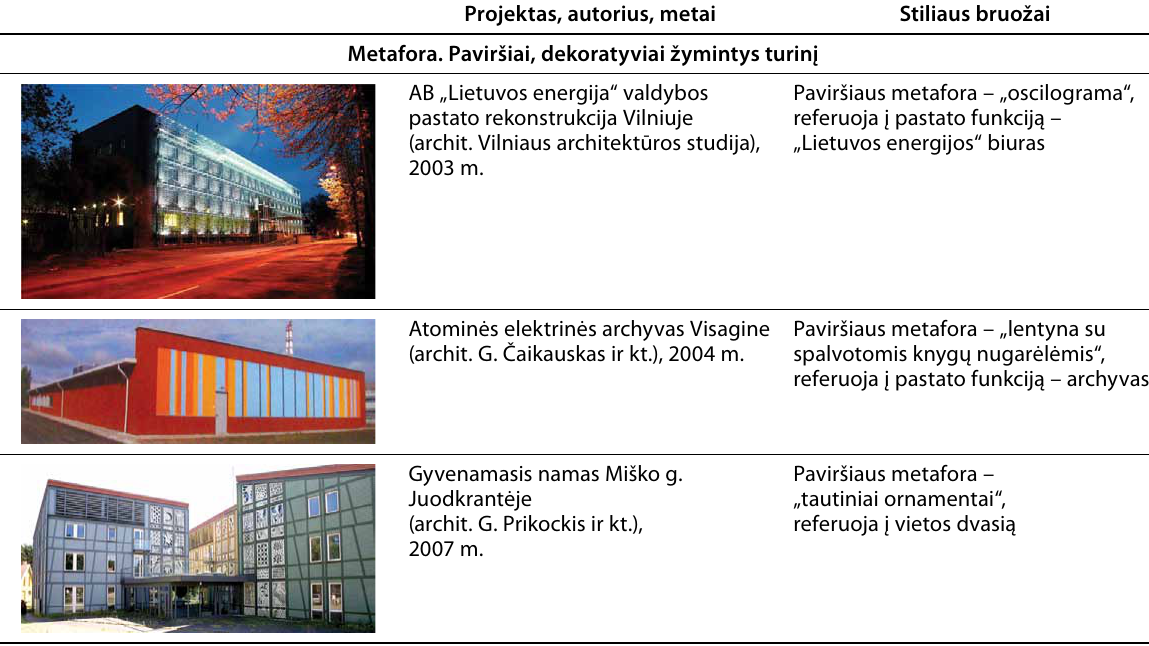
Table 2. architectural examples of metaphorical surfaces in lithuania Projektas, autorius, metai Stiliaus